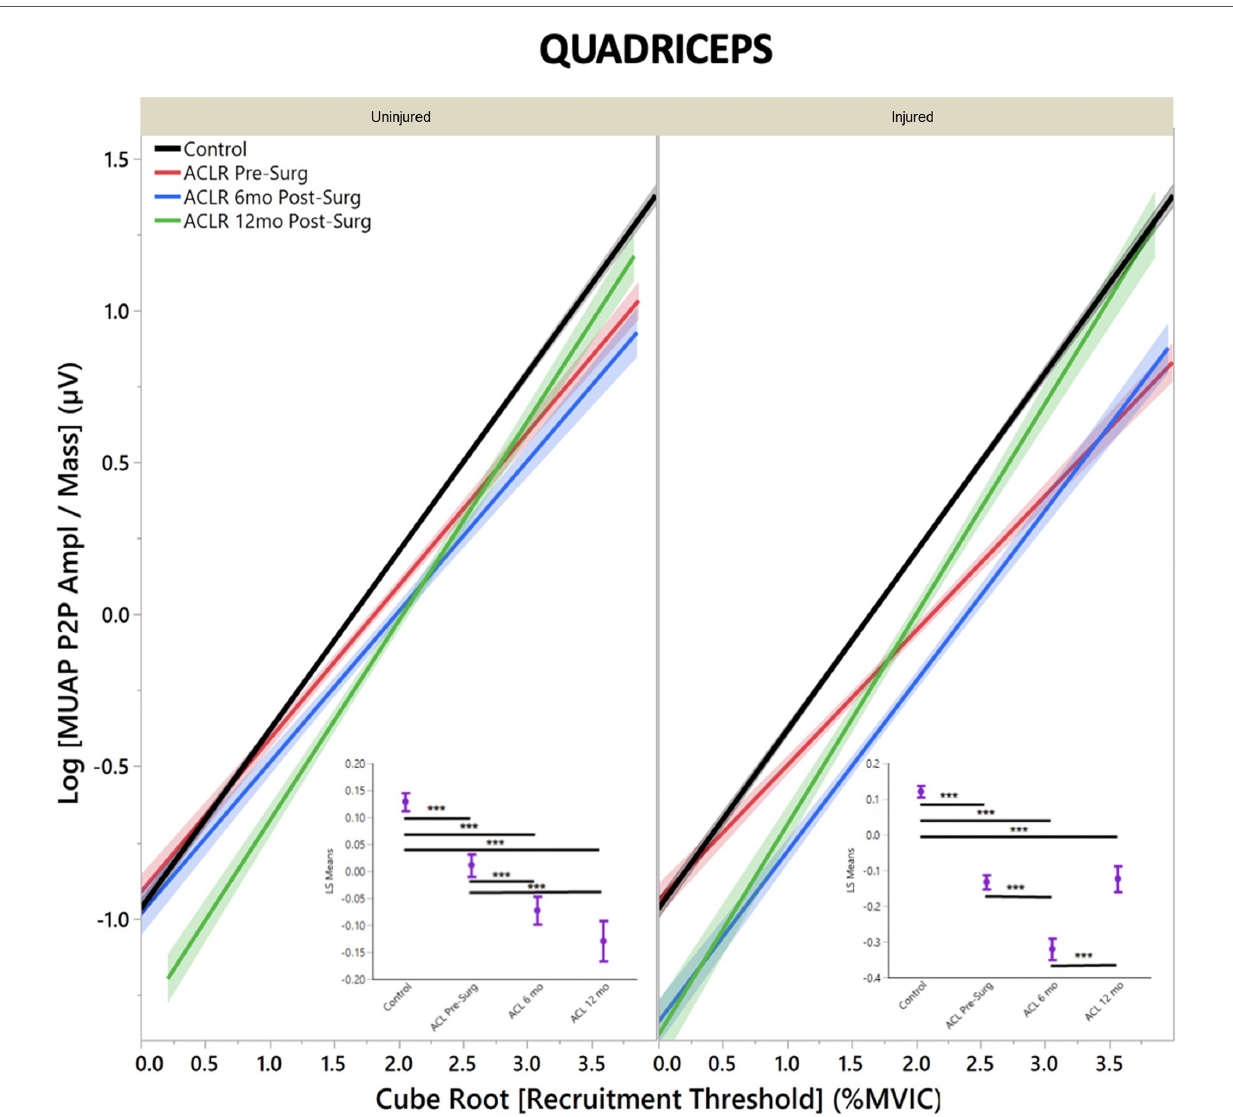
FIGURE 1 Quadriceps motor unit action potential by group for uninjured and injured limbs. MUAP peak-to-peak amplitude represents motor unit size. ( Insets ) Least means square ANOVA demonstrates signi fi cant differences of MUAP between groups. (* denotes p <0.05; *** denotes p <0.001; line shading and error bars denote 95% con fi dence intervals of the